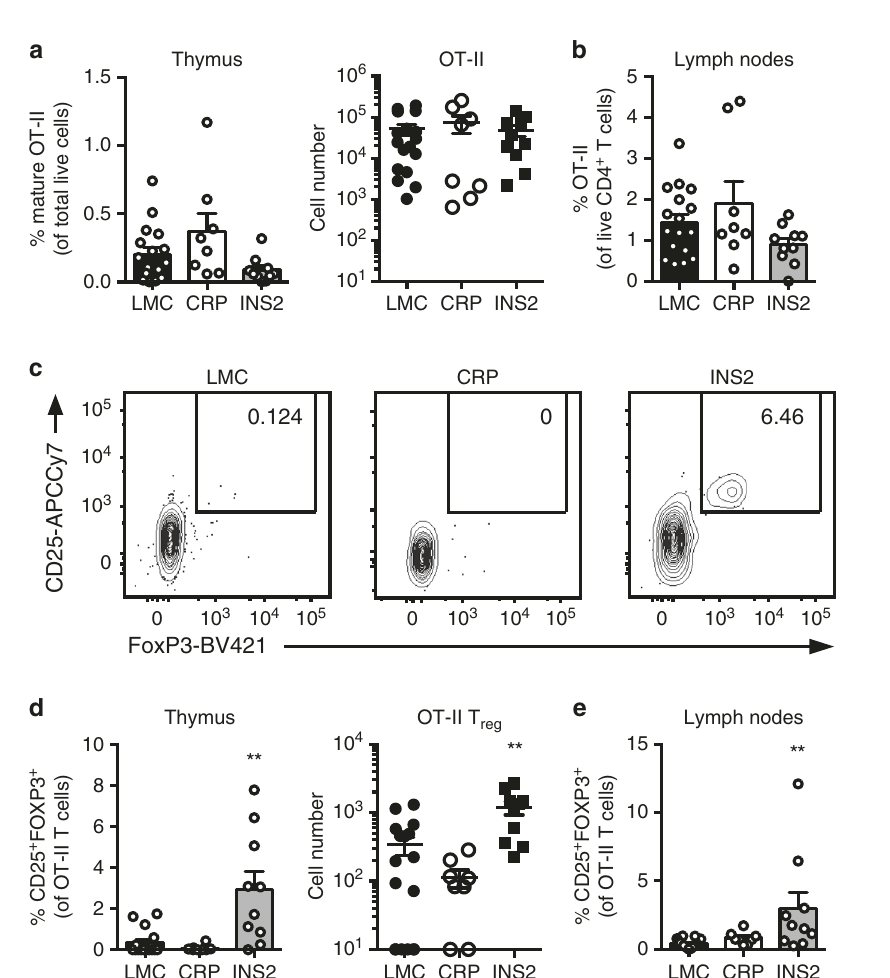
Fig. 4 mTEC hi -restricted expression of USA preferentially induces T reg differentiation. Littermate control (LMC), CRP, and INS2 Tg mice (CD45.2, Thy1.2) were irradiated and reconstituted with 1% OT-II (CD45.2, Thy1.1) and 99% WT (CD45.1, Thy1.2) bone marrow. The hematopoietic chimeras were analyzed 6-8 weeks post-irradiation. a Proportion of mature TCR β hi CD4 + SP OT-II thymocytes among total live cells and absolute number of live CD4 + SP OT-II thymocytes. b Proportion of OT-II cells within the CD4 + T cell population in the peripheral lymph nodes. c Representative fl ow plots of CD25 and FoxP3 expression on OT-II T cells. d Proportion and absolute cell number of CD25 + Foxp3 + OT-II T cells in the thymus. e Proportion of CD25 + Foxp3 + OT- II T cells in the lymph nodes. (mean ± SEM, n = 17 LMC, 8 CRP, 10 INS2, from three independent experiments). All p -values indicated are calculated by Kruskal-Wallis test followed by Dunn ’ s post-hoc comparisons to LMC, two-sided. ** p < 0.01 relative to LMC. Source data are provided as a Source Data fi